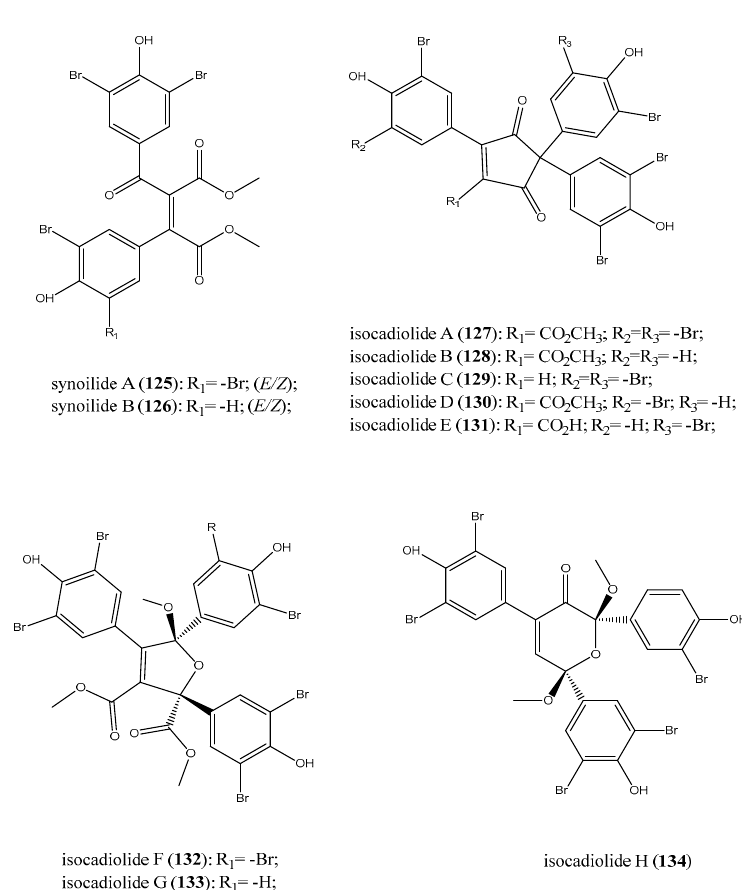
Figure 13. Structures of synoilides A ( 125 ) and B ( 126 ) and isocadiolides A–H ( 127 – 134 ).